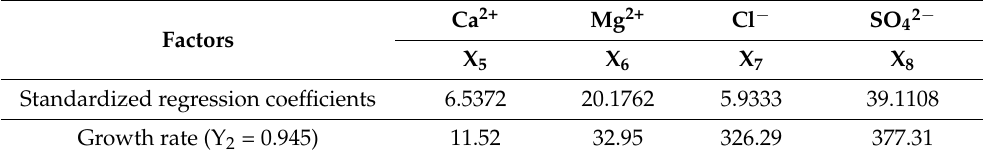
Table 7. The standardized regression coefficients of the model and optimal combination.